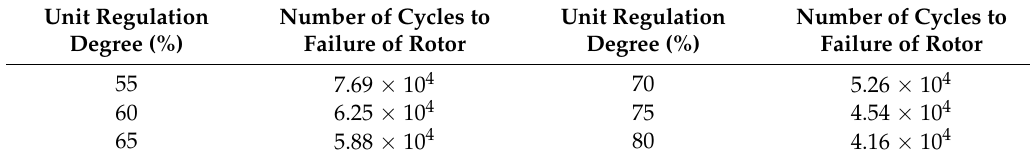
Table 3. Unit loss data.